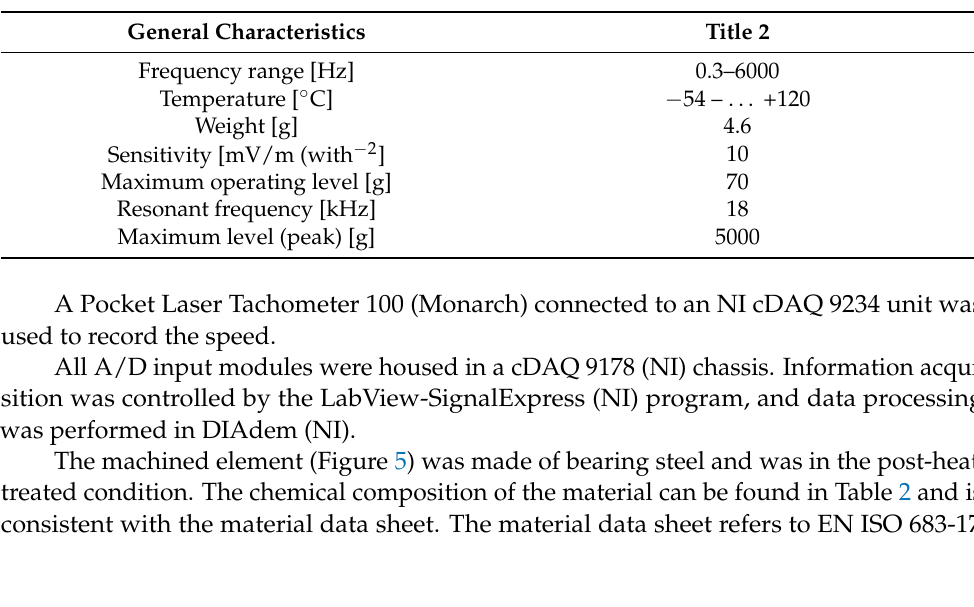
Table 1. Technical data of the CCLD piezoelectric accelerometer.